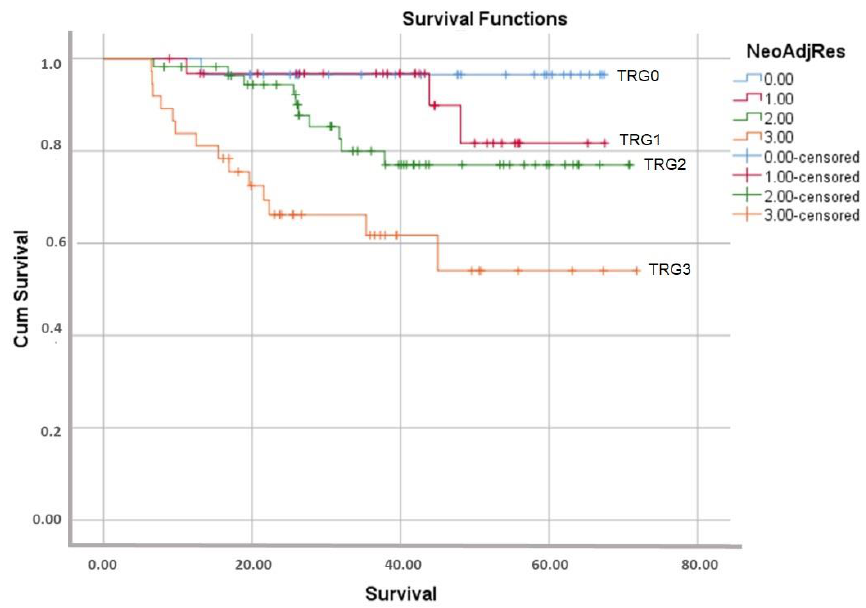
Figure 6. Kaplan–Meier curve on the overall survival between different Figure 6. Kaplan – Meier curve on the overall survival between different TRGs.